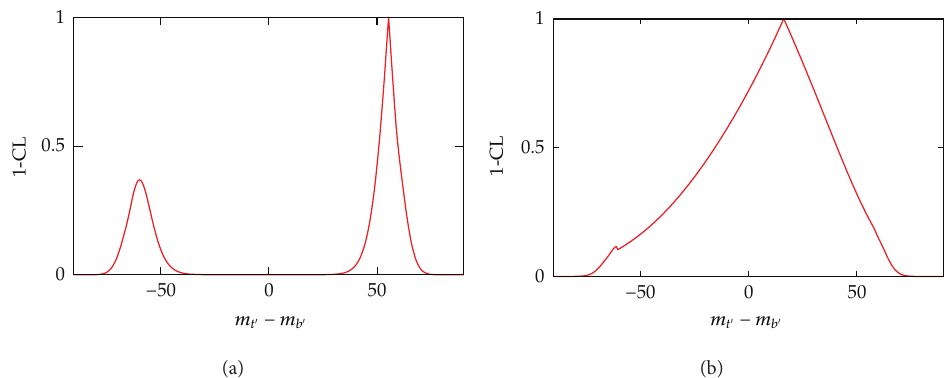
Figure 3: Allowed mass splitting of fourth generation quarks according to the constraints from electroweak precision observables. (a) CKM mixing is forced to be zero, (b) it is allowed to an extent that does not violate any bound from flavor physics. For both pictures the lepton masses were fixed.